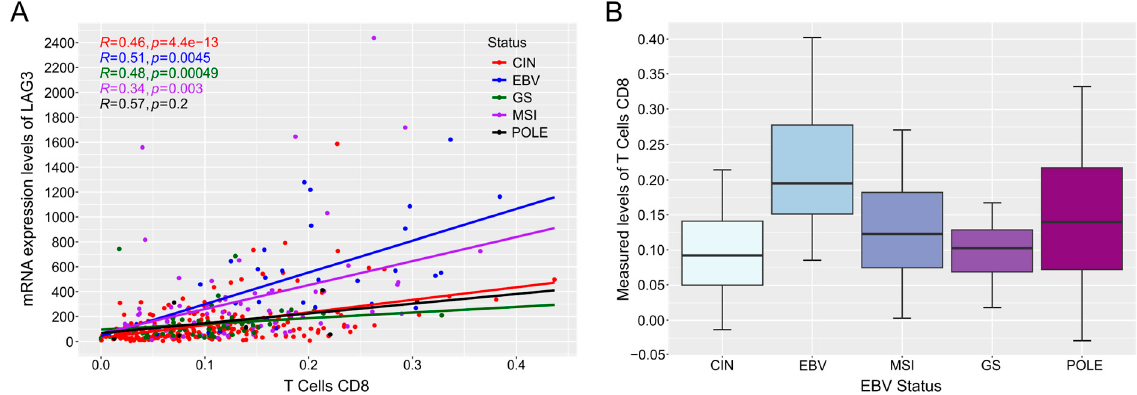
Figure 3. Sample ( A ) correlation plot of LAG3 (Gene ID: 3902) with CD8 T cell fraction (T Cells CD8) in the tumor microenvironment, and ( B ) boxplot representing the distribution of the CD8 T cell fraction across the 5 GC subtypes. This figure was generated natively in the EBV-GCR web suite using the correlation of mRNA gene expression with the immune landscape tool.